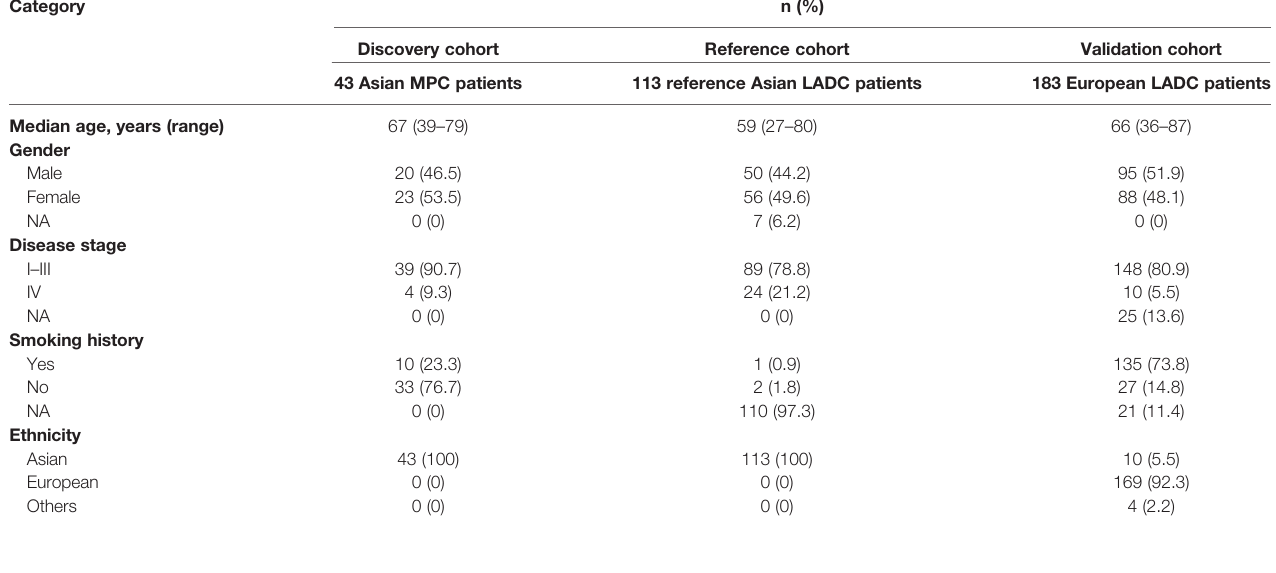
TABLE 1 | The demographic characteristics of different patient